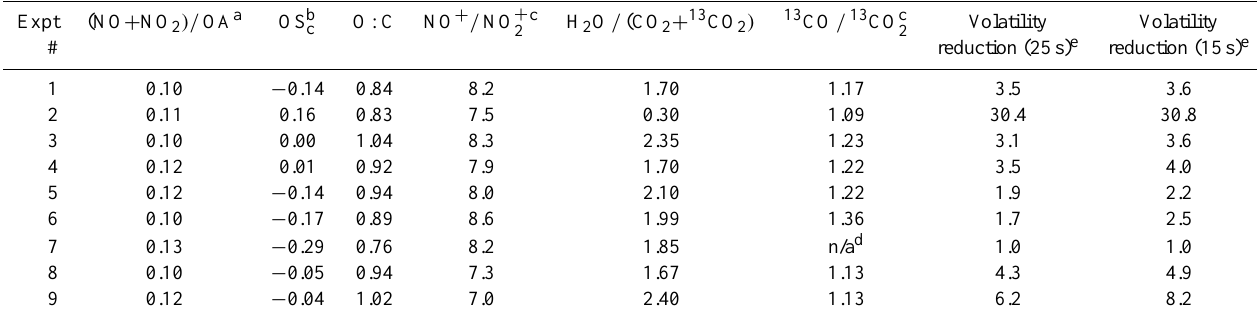
Table 2. Summary of organic aerosol composition and